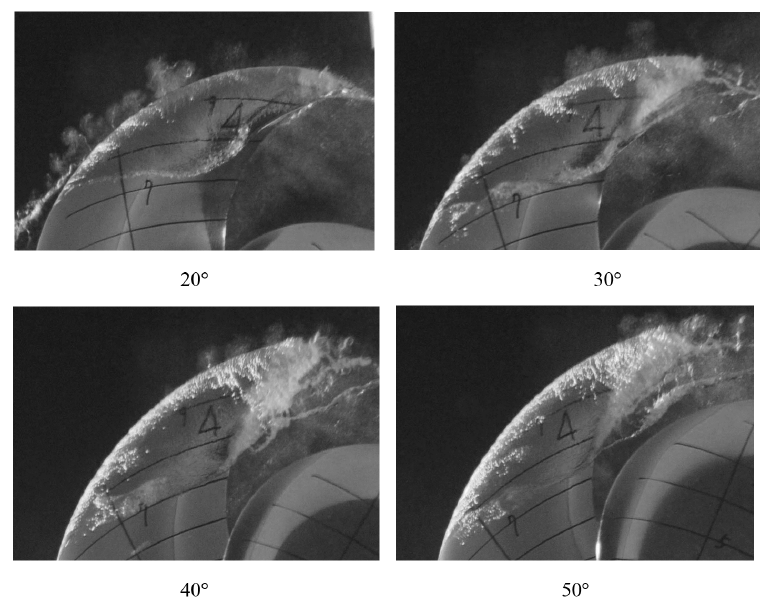
Figure 14. Photographs of the propeller sheet cavitations at the blade angles from 20° to 50°.